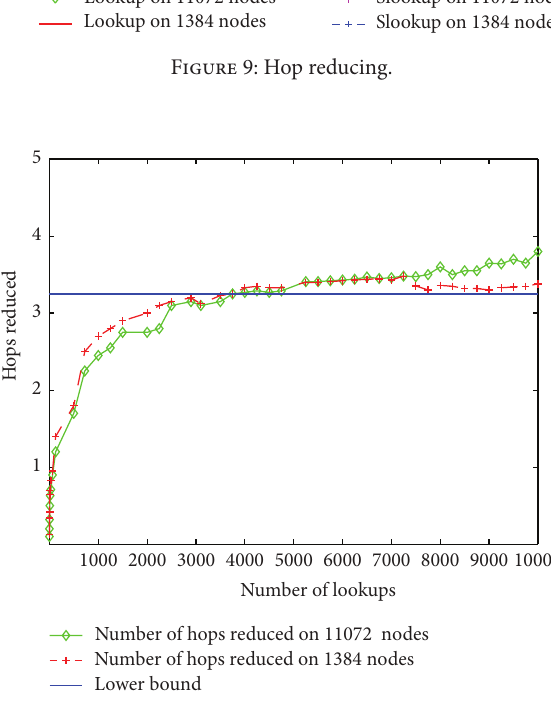
Figure 8: Prediction of expected lookup and slookup hops.